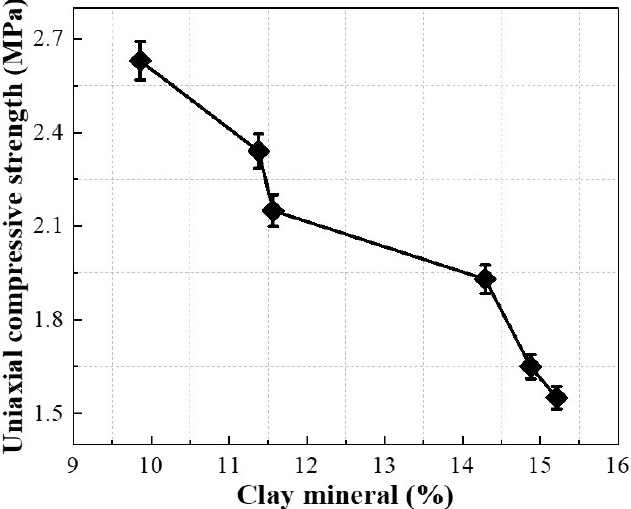
Figure 12. Relationship between clay mineral content and uniaxial compressive strength.